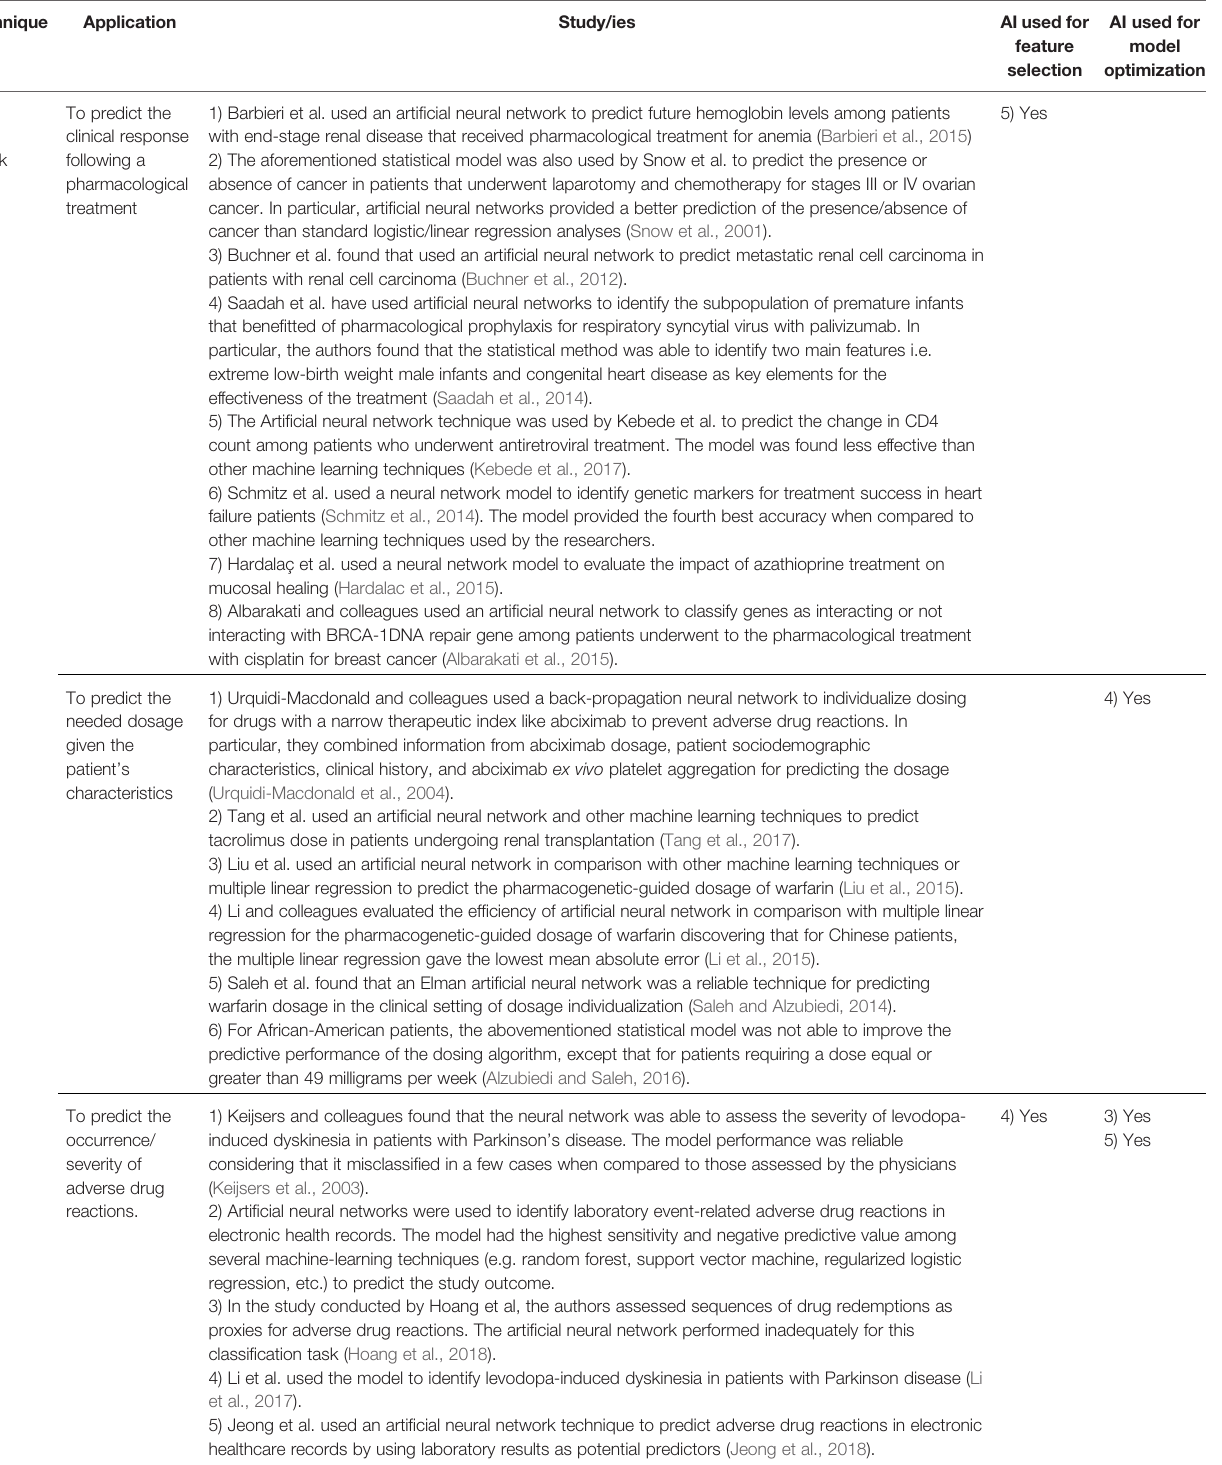
TABLE 1 | Main applications of knowledge discovery methods of arti fi cial intelligence (AI) in